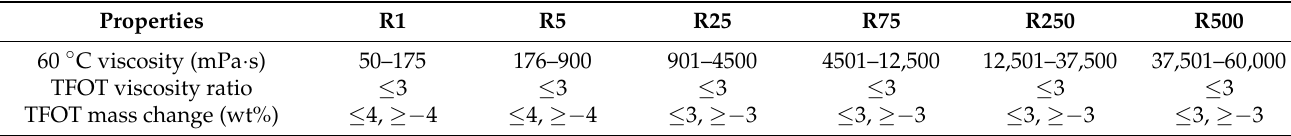
Table 4. The technical requirements of rejuvenators.